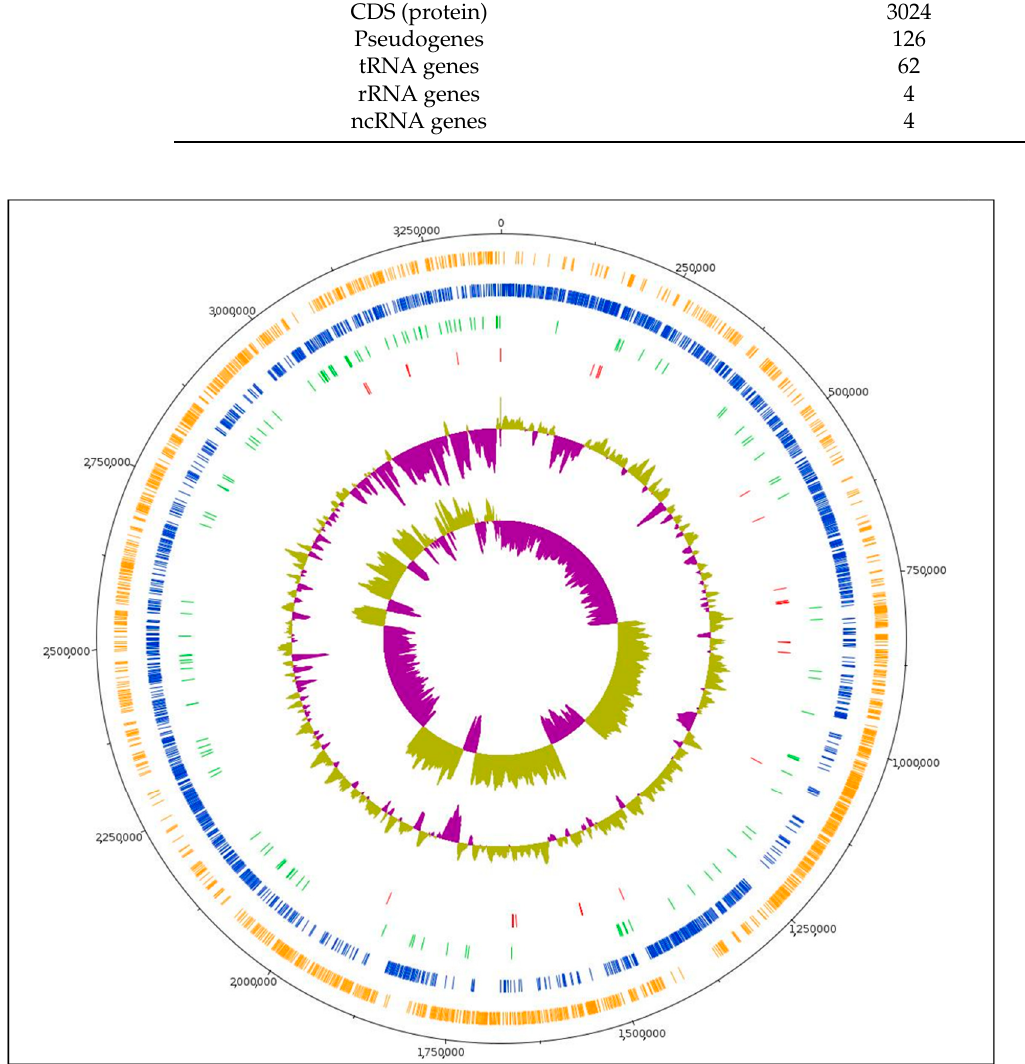
Figure 1. Circular genome map of L. plantarum L125. From the outer to inner circle, the information is displayed as follows: genome size (black), forward strand CDS (orange), reverse strand CDS (blue), pseudogenes (green), tRNA genes (red), GC content, GC skew. Table 1. L. plantarum L125 genome features.